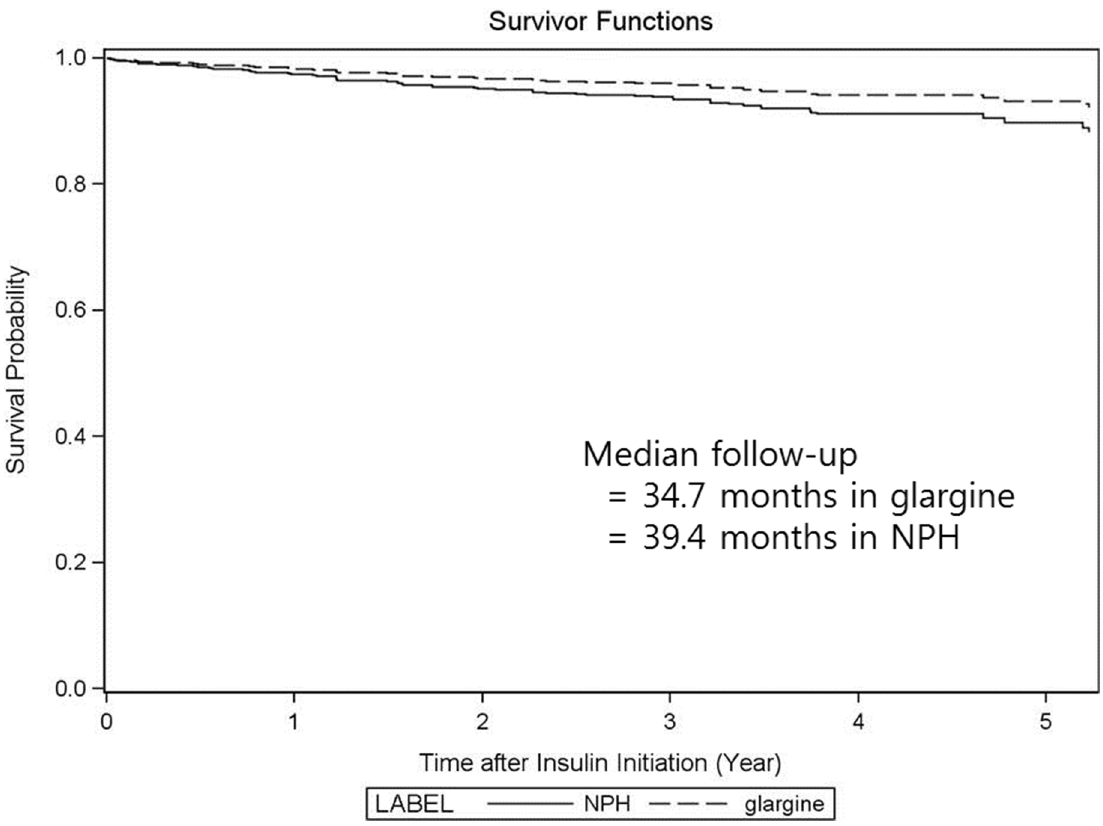
Figure 1. Cancer free survival curves in new glargine and NPH insulin users.